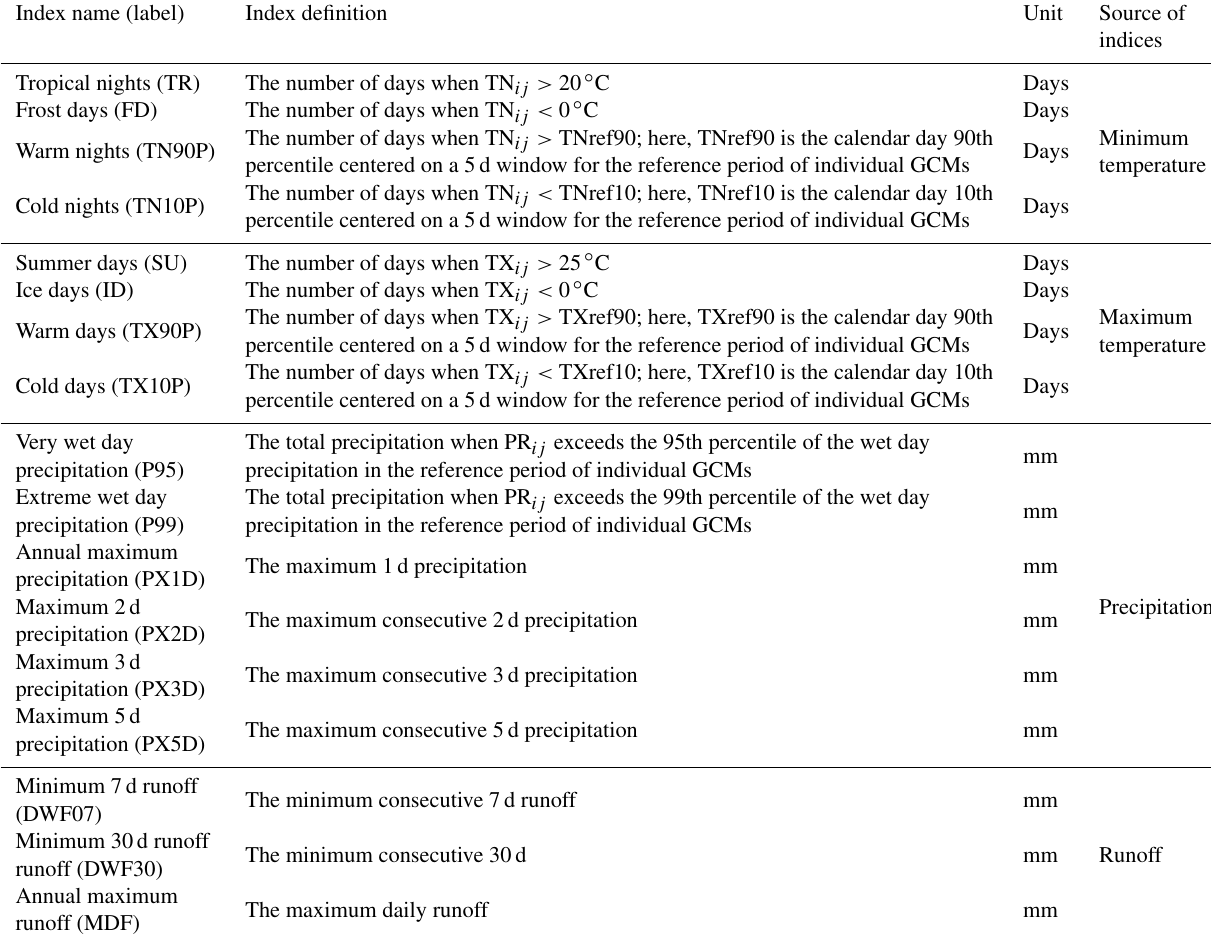
Table 4. Definitions of the hydroclimatic extreme indices using minimum temperature (denoted by TN), maximum temperature (denoted by TX), precipitation (denoted by PR), and runoff data, where “ i ” and “ j ” represent the month and year,